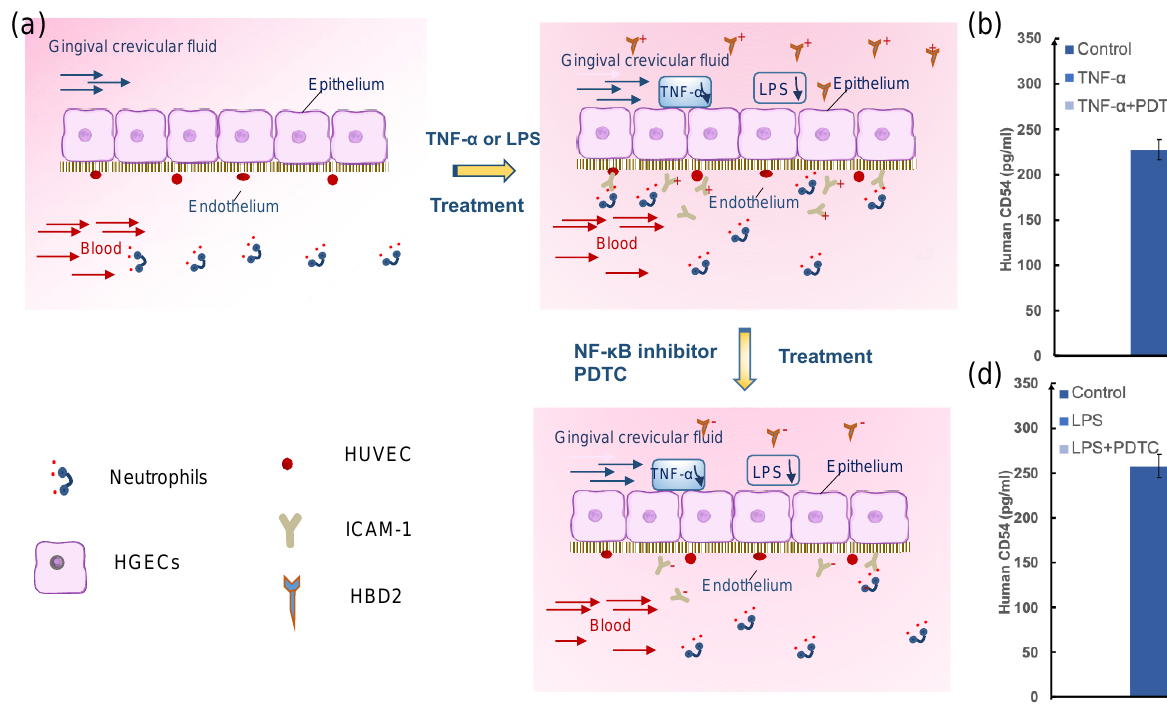
Figure 7. Periodontal soft tissue inflammation and therapeutic responses on-chip. ( a ) Schematic diagram of inflammation model and drug model; ( b , c ) the graphs show effects on production of the human CD54 (ICAM-1), Human DEFB2 (HBD2) stimulation with TNF- α (10 ng mL −1 ) in the absence or presence of medicine on the epithelium-capillary interface chip; ( d , e ) The graphs show effects on production of the ICAM-1, HBD2 stimulation with LPS (10 μg mL −1 ) in the absence or presence of PDTC on the epithelium–capillary interface chip. n = 3. Error bars represent the standard error of the mean (SEM) of three independent experiments. Two-tailed significance was set to * p < 0.05 and ** p < 0.01, *** p < 0.001.